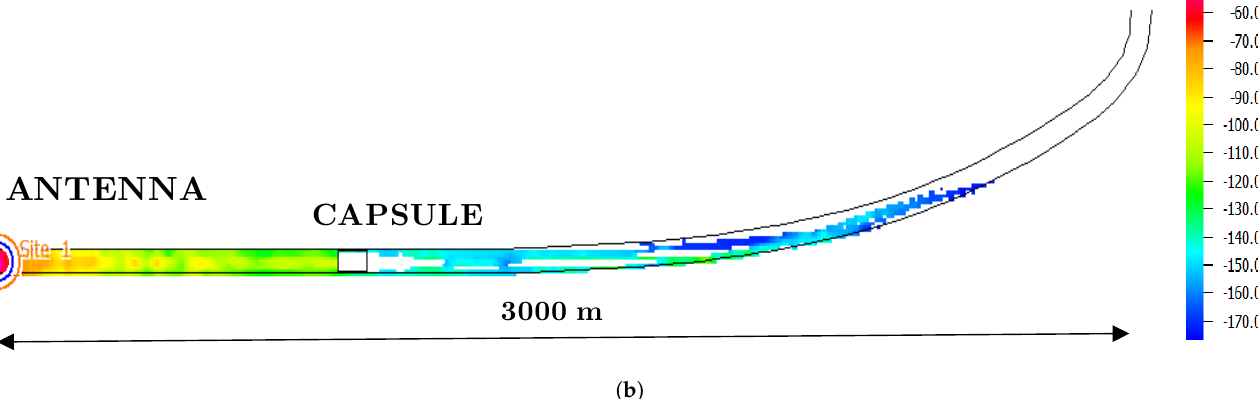
Figure 5. Simulation with ray tracing technique of 1000 m straight ( a ) and 3000 m curved steel tube ( b ) at 24